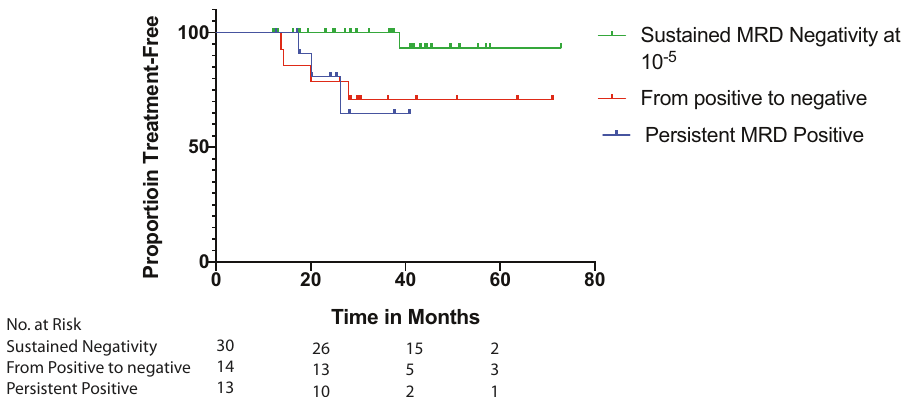
Fig. 4 Kaplan Meier curves for time to next treatment (TTNT) according to sequential MRD measurements. According to Sequential MRD Status, with starting point from fi rst negative MRD assessment. Median TTNT was not reached in any